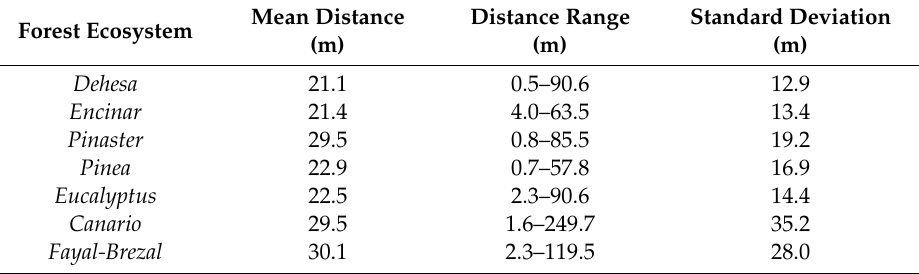
Table 4. Distance between sampling positions in the 3rd and 4th National Forest Inventory (NFI). The mean value and the standard deviation of the computed distances are presented for the selected forest